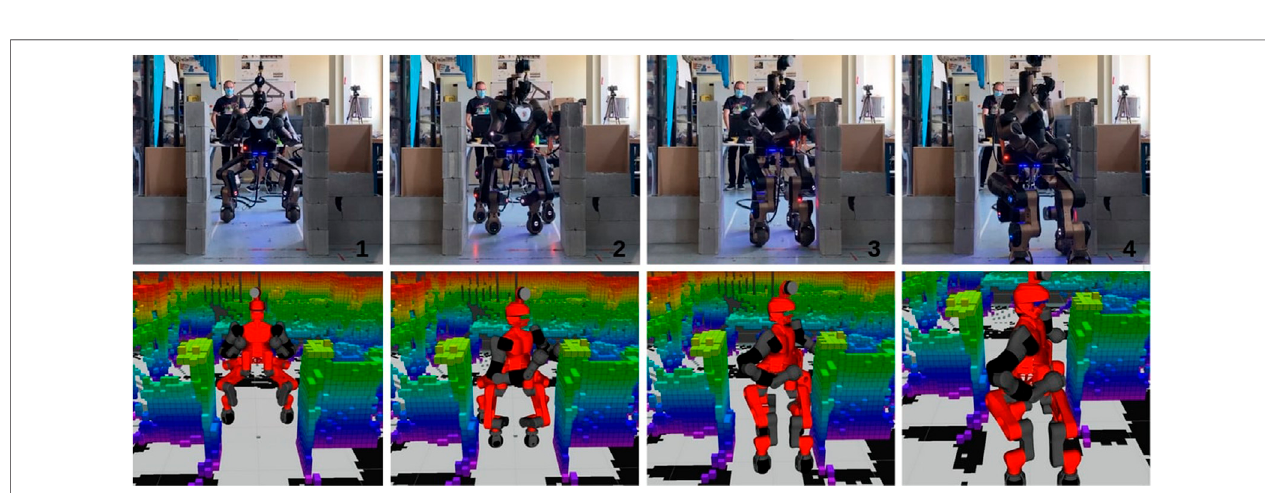
FIGURE 9 | Screenshots from the experiment carried out on a CENTAURO robot. From top left to bottom right, the robot fi rst approaches the narrow corridor keepingthehomingpositionasfarasnocollisionsaredetected.Assoonastherobotstartsenteringthecorridor,theNSPGreshapesthesupportpolygonandtheupper body at the same time.